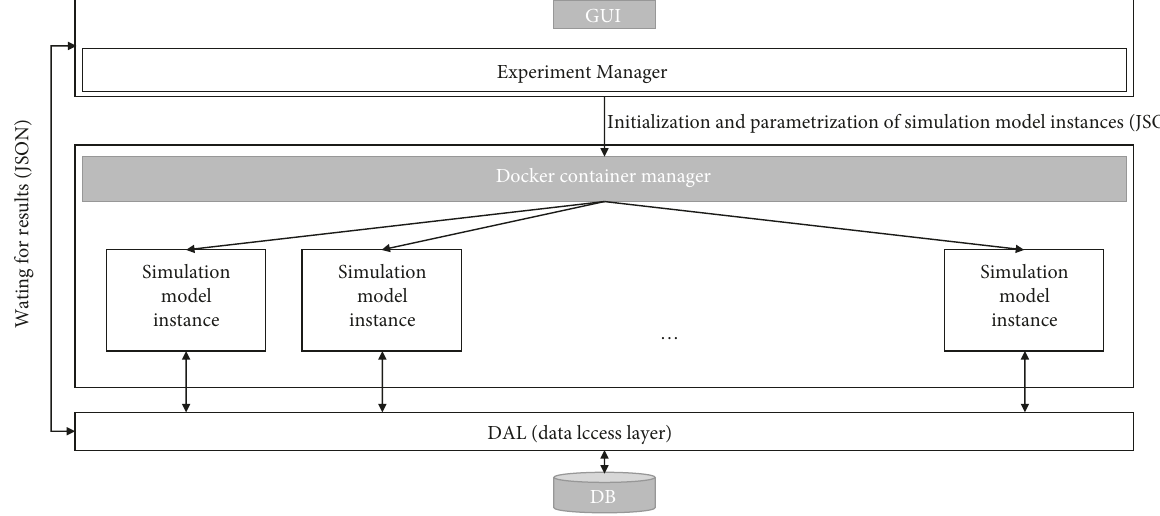
Figure 7: Web application architecture for simulation management/visualization (extended by the Docker Container Manager).